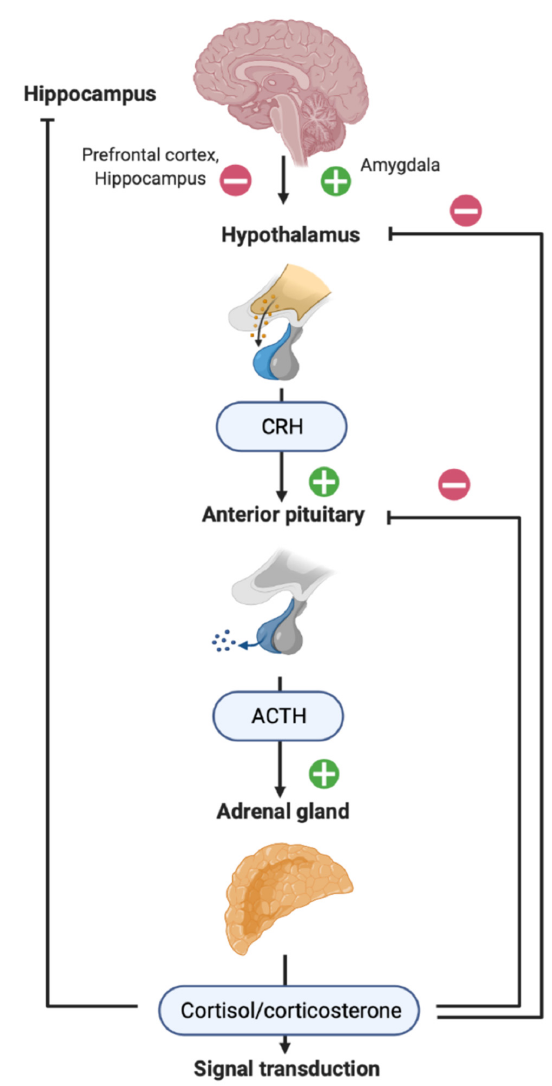
Figure 1. Hypothalamic–pituitary–adrenal (HPA) axis. Neuroendocrine response to stress includes the reaction of HPA axis: the release of hypothalamic corticotropin-releasing hormone (CRH),